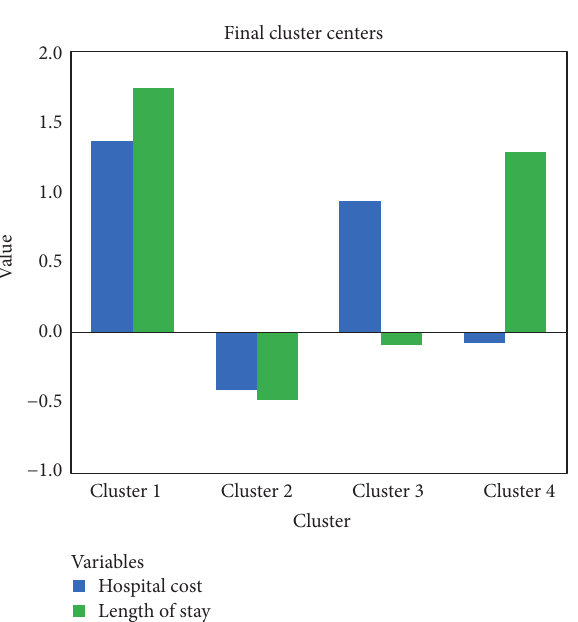
Figure 2: Cluster with surgical